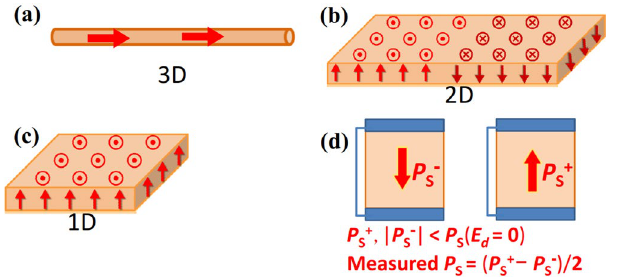
Figure 2. Definition of ( a ) three, ( b ) two, ( c ) one-dimensions for FE in this article. Dimensionality is not referred to the shape of an object. θ is the angle between the normal to the surface in ( c ) and the direction of P S . ( d ) Typical measurement of P S in a capacitor. This is smaller than bulk P S ( E d = 0), because of nonzero screening length in